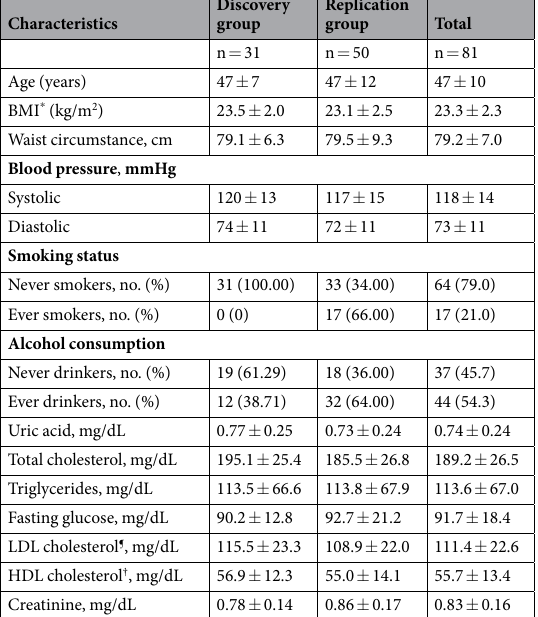
Table 1. Demographic characteristics. Values are presented as mean ± standard deviation (SD) for continuous data. * The body mass index (BMI) was calculated as weight in kilograms divided by height in meters squared; ¶ LDL Cholesterol: Low-Density Lipoprotein Cholesterol; HDL Cholesterol: † High-Density Lipoprotein